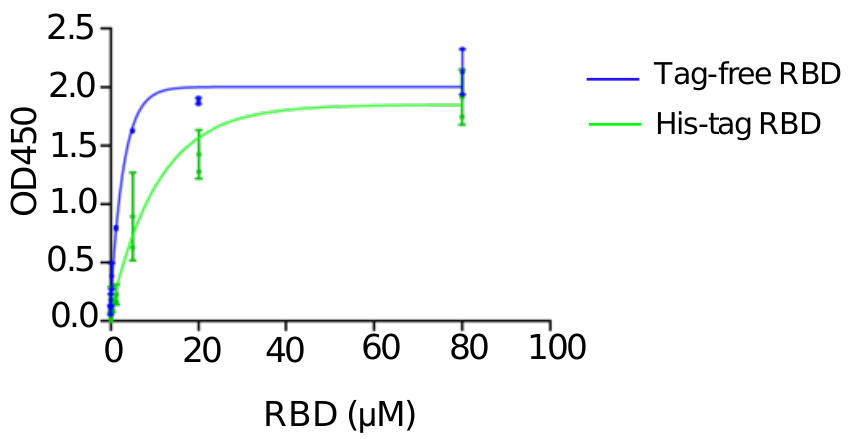
Figure 2. hACE2 binding assay for tag-free RBD (blue) and His-tag RBD (green). Data are presented as mean ± SD.